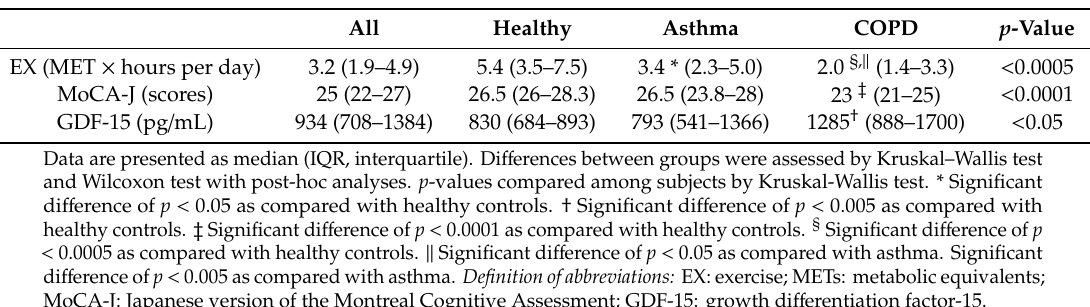
Table 2. Comparison of physical activity (EX), cognition level (MoCA-J), and growth di ff erentiation factor-15 (GDF-15) among subjects.